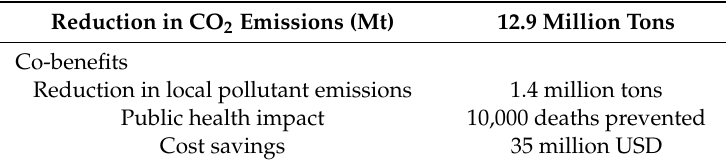
Table 10. Expected co-benefits from the TTMP in 2030.